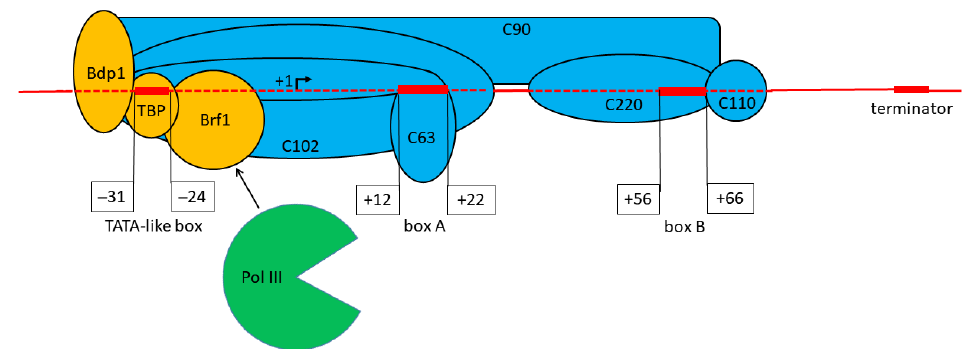
Figure 1. A complex of TFIIIB and TFIIIC with a gene carrying a type 2 promoter for pol III. The subunits of TFIIIB and TFIIIC are colored yellow and blue, respectively. Pol III (green) is shown as disproportionately small and without subunits. The TSS is indicated as +1. The TATA-like box, box A, box B, and transcription terminator are shown as red rectangles; the positions of the boxes relative to the TSS are specified.